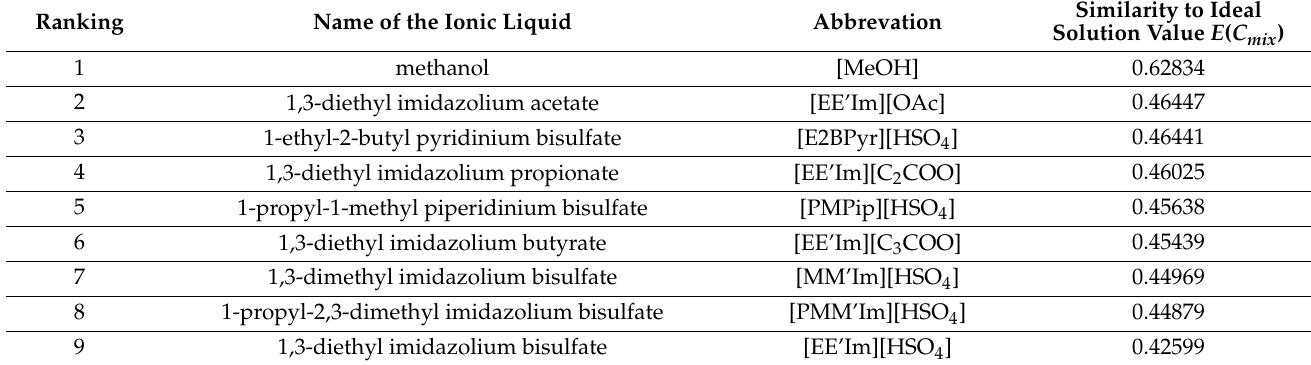
Table 2. Table showing the TOPSIS ranking of halide free